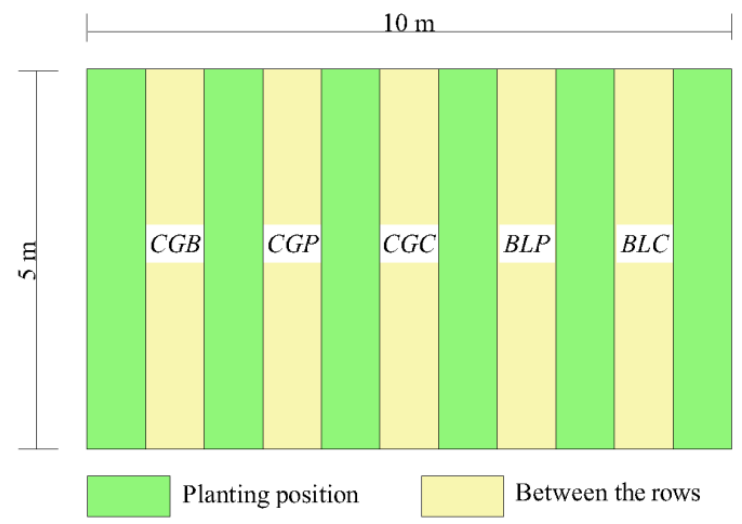
Figure 2. Schematic diagram of the experimental layout.